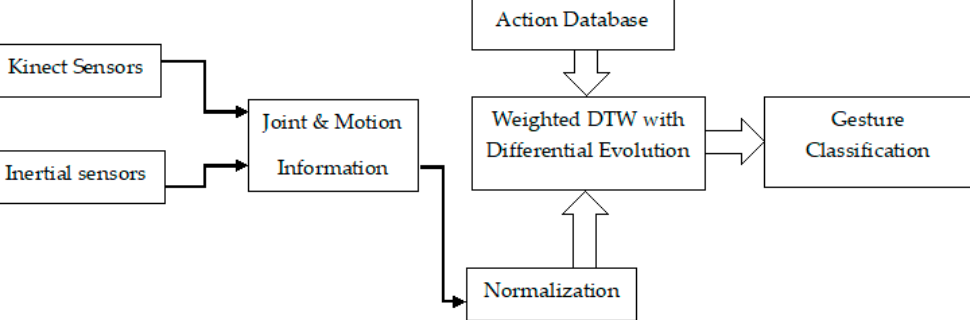
Figure 3. Gesture Recognition of Weighted DTW with Differential Figure 1. Gesture Recognition of Weighted DTW with Differential Evolution.